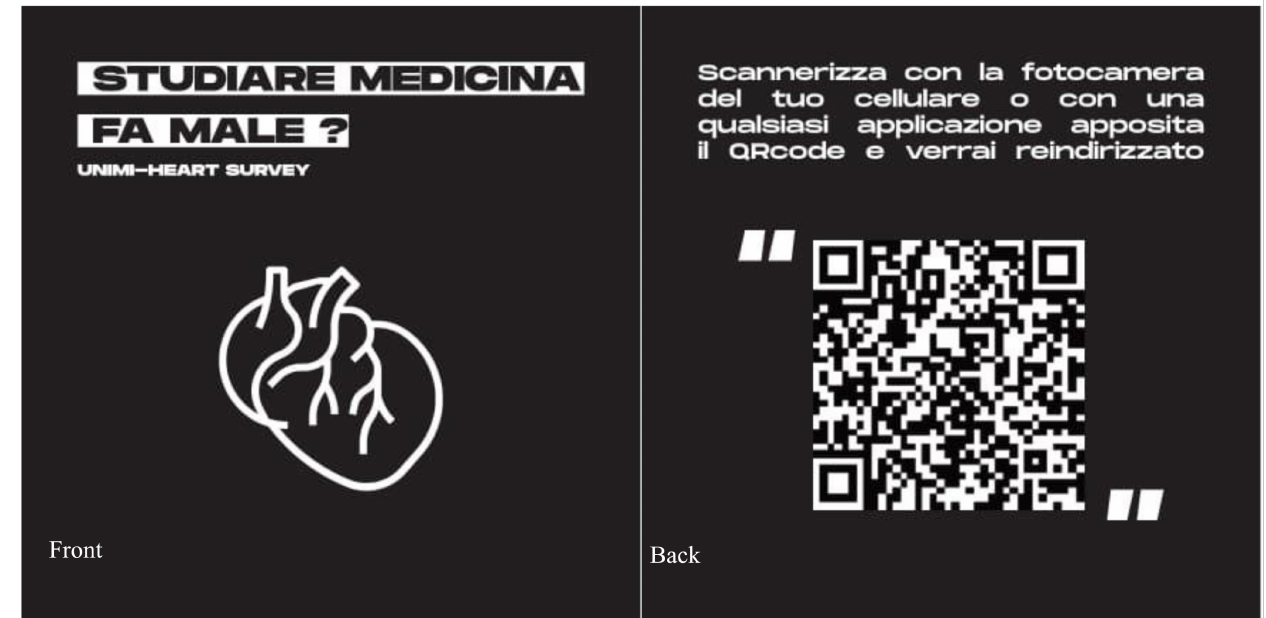
Figure 1. QR code flyer. Front and back of QR code flyer delivered to the